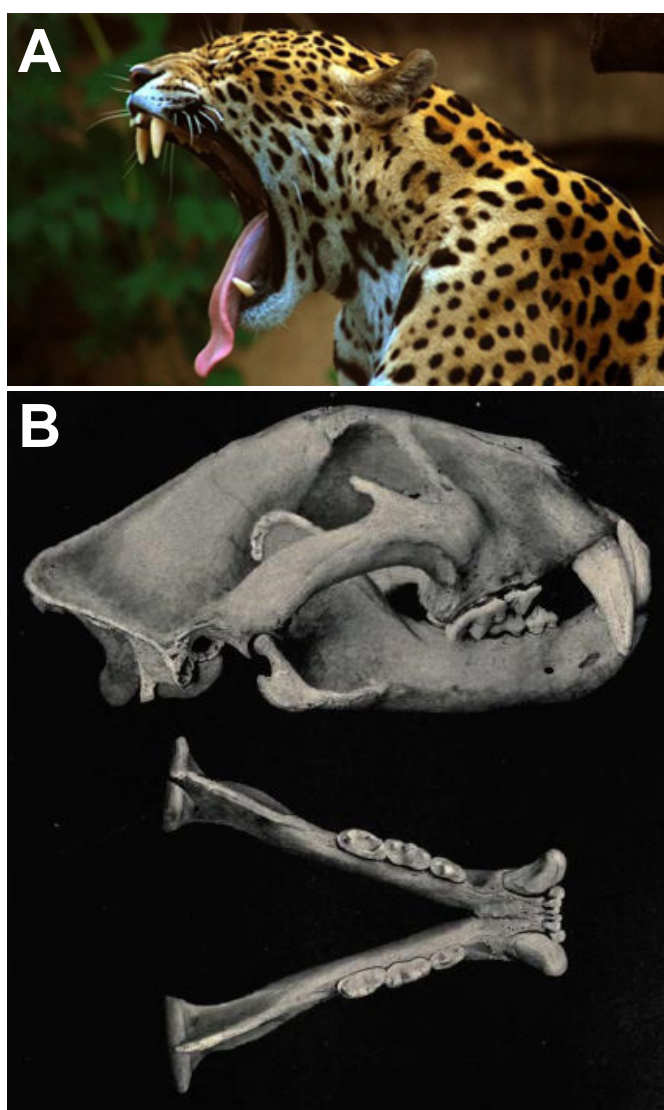
Figure 1. A , Jaguar (used by permission; Panthera onca , jaguar © MarcusObal, Creative Commons Attribution-Share Alike